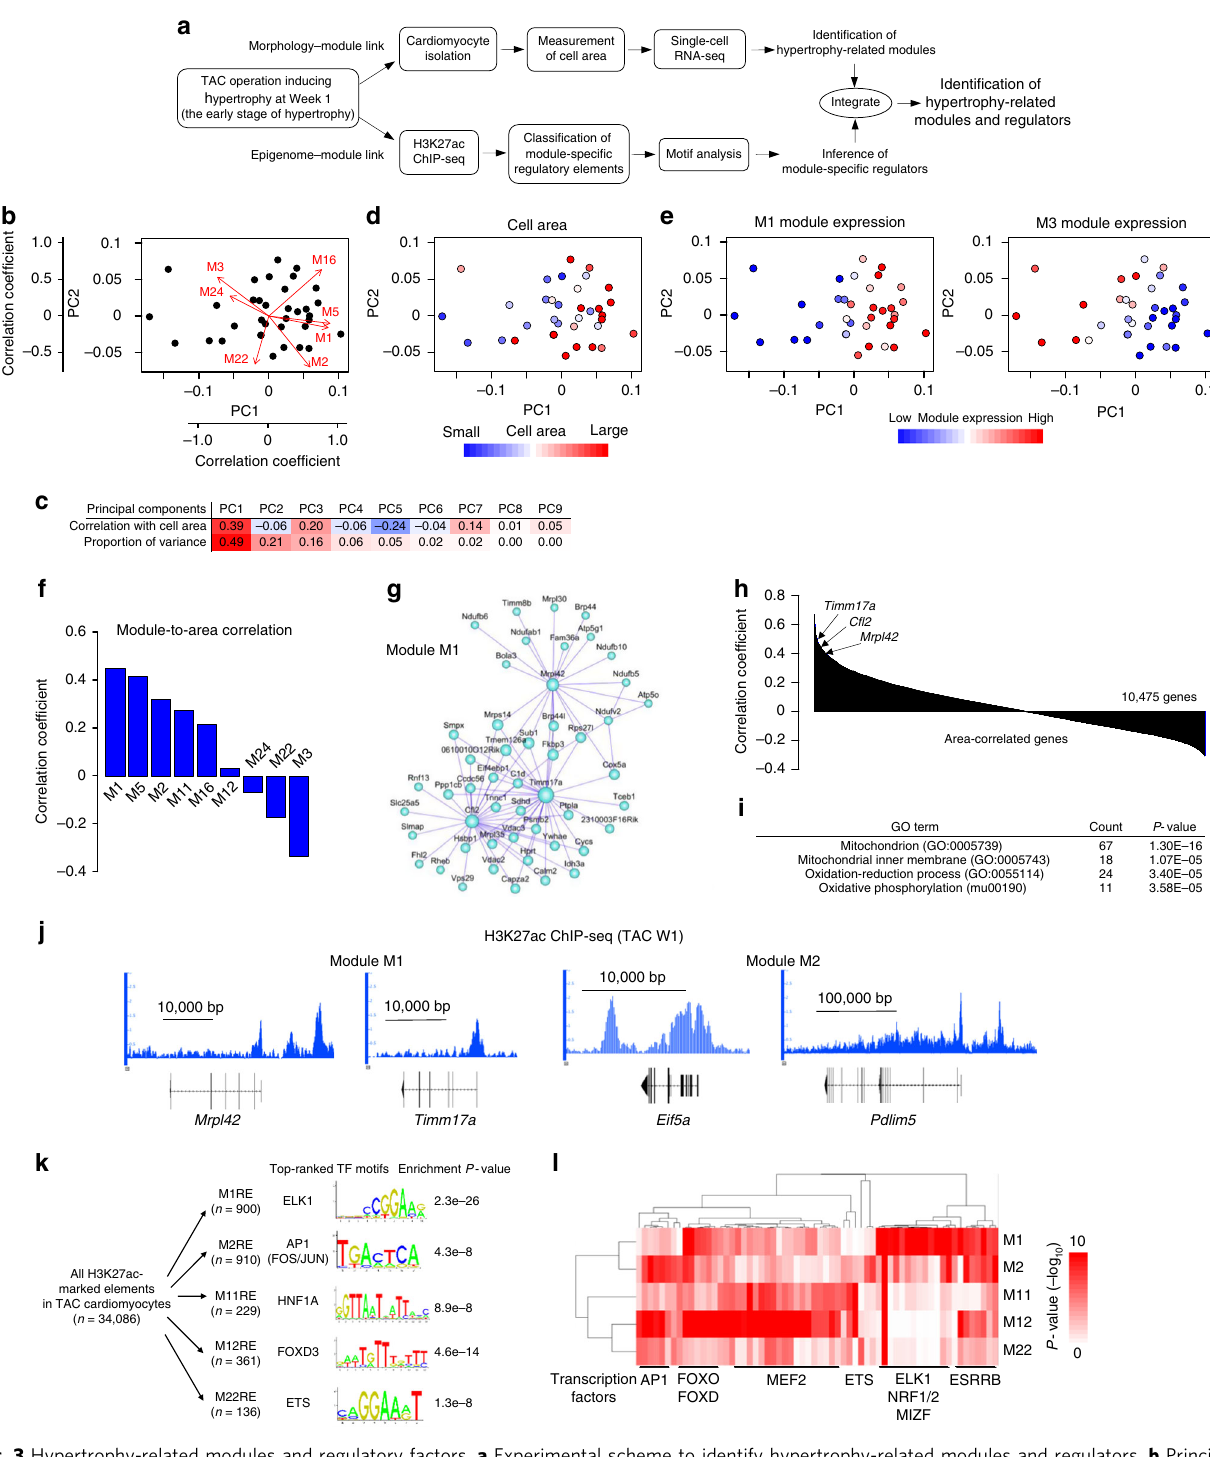
Fig. 3 Hypertrophy-related modules and regulatory factors. a Experimental scheme to identify hypertrophy-related modules and regulators. b Principal component analysis (PCA) plot of cardiomyocytes from mice at 1 week after TAC in a . Arrows denote the correlation coef fi cients of the respective module with each principal component. c Correlation coef fi cient with cell area and proportion of variance for each principal component. d , e PCA plots colored by the cell area ( d ) and by the expression of each module ( e ). f Bar plot showing the correlation coef fi cient between cell area and module expression. Modules are ordered by the correlation levels. g Hub gene network of M1. The size of the dots represents node centrality. h Bar plot showing the correlation coef fi cient between cell area and gene expression. Genes whose expression was detected in at least one of the samples are ordered by correlation levels. i List of the most enriched GO terms in the top 300 correlated genes with cell area. j Representative genome browser views of H3K27ac ChIP-seq of cardiomyocytes from mice at 1 week after TAC. The Y -axis indicates reads per million (range, 0 – 3). k Transcription factor recognition motifs most signi fi cantly enriched in the regulatory elements (REs) for each module. l Hierarchical clustering of transcription factor recognition motifs. The top 10 signi fi cantly enriched motifs for each module are selected. Transcription factors strongly expressed in cardiomyocytes are shown below the